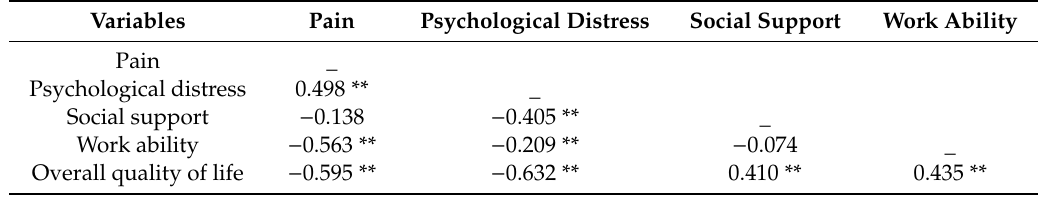
Table 3. The correlations of research variables and the reliability for the scales.